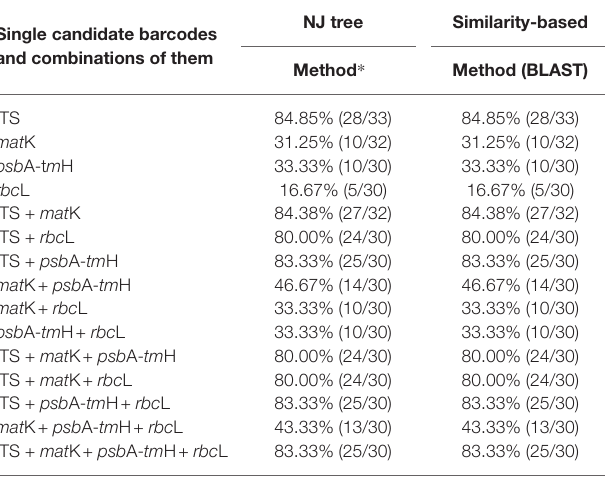
TABLE 2 | Identification success rates obtained using NJ tree and local blast analysis methods for each single candidate barcodes and combinations of them. NJ Single candidate barcodes and combinations of them